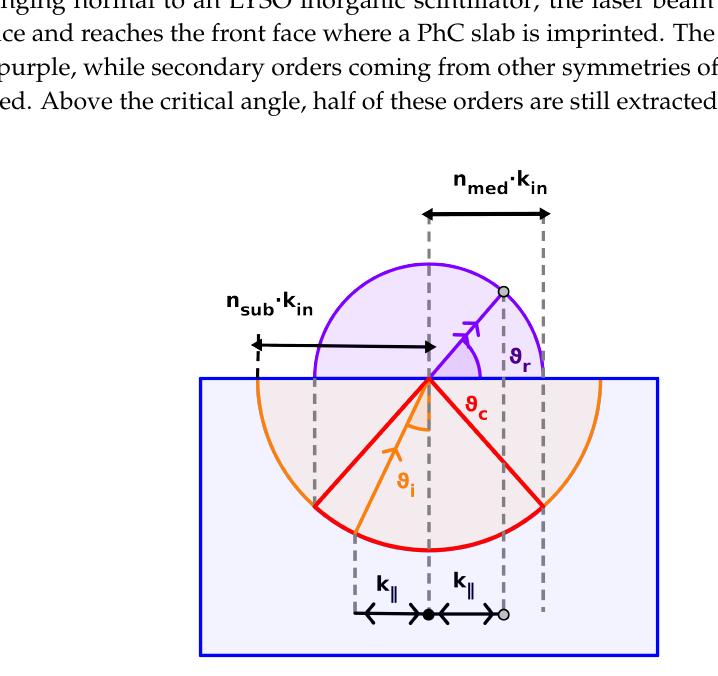
Figure 7. K-vector representation of Snell’s law. The module of the incident wave vector is shown as an orange hemisphere, while the module of the outgoing wave is the purple